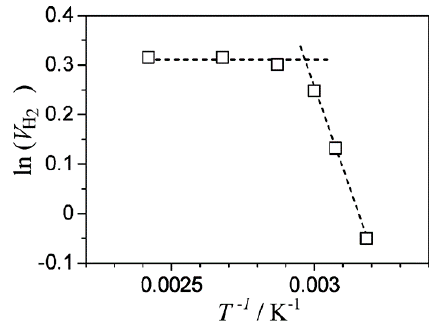
Figure 16. Arrhenius plot constructed using the production rate of H 2 . Reprinted with permission from [23]. Copyright (2010), American Chemical Society.